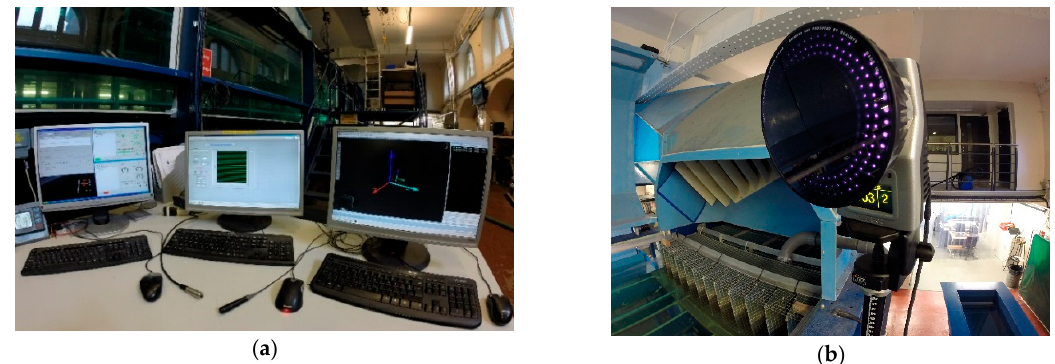
Figure 6. Tank control and data acquisition system. ( a ) Qualisys control and measurement system and ( b ) Oqus motion capture camera